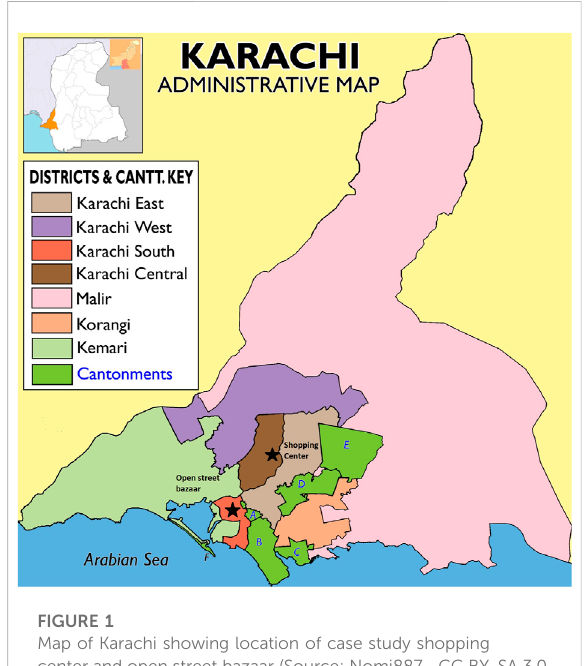
FIGURE 1 Map of Karachi showing location of case study shopping center and open street bazaar (Source: Nomi887 — CC BY-SA 3.0, Wikimedia